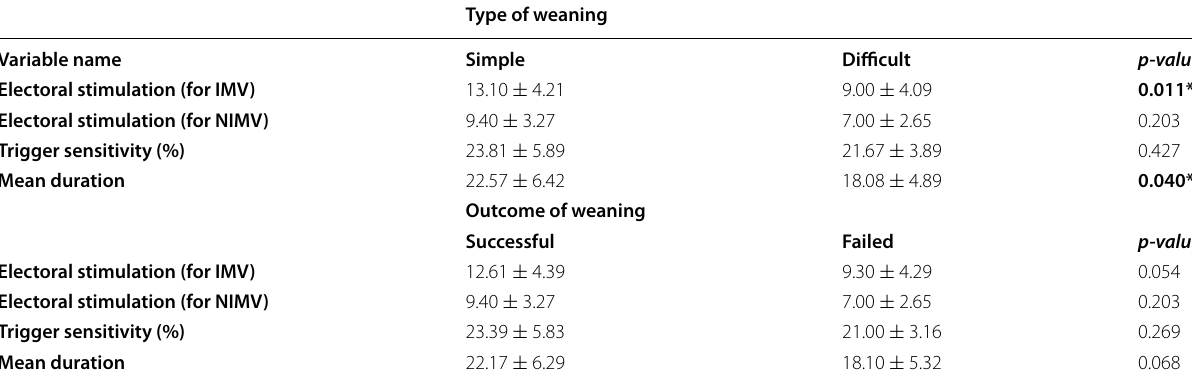
Table 5 Rehabilitation parameters based on weaning outcome